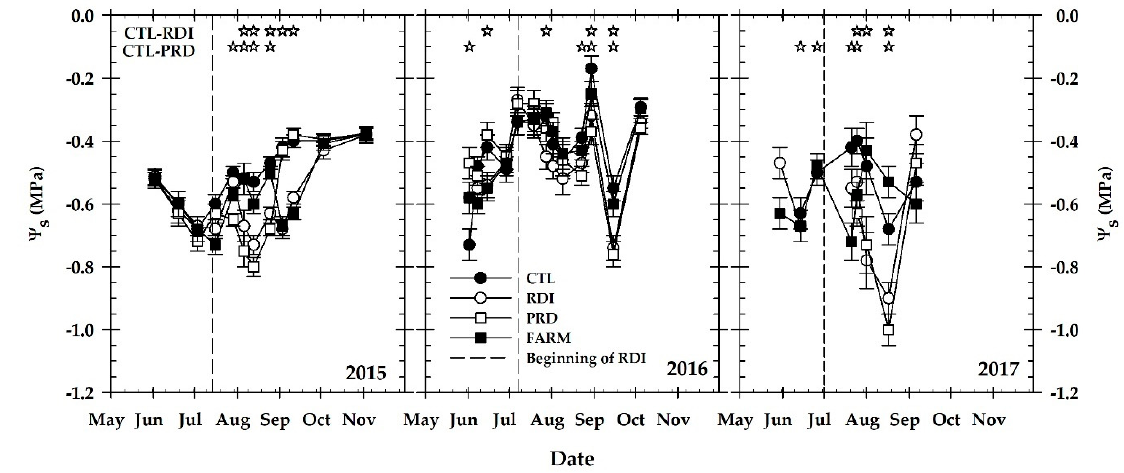
Figure 3. Seasonal evolution of midday stem water potential ( Ψ s , MPa) for all irrigation treatments: CTL (black circles), RDI (white circles), PRD (white squares) and FARM (black squares) during the three years assayed (2015–2017). Each point is the mean ± SE of n = 6 leaves, per irrigation treatment. The dashed line indicates the start of water deficit period. Stars indicate statistically significant differences between treatments according to Duncan’s multiple range test ( p < 0.05).